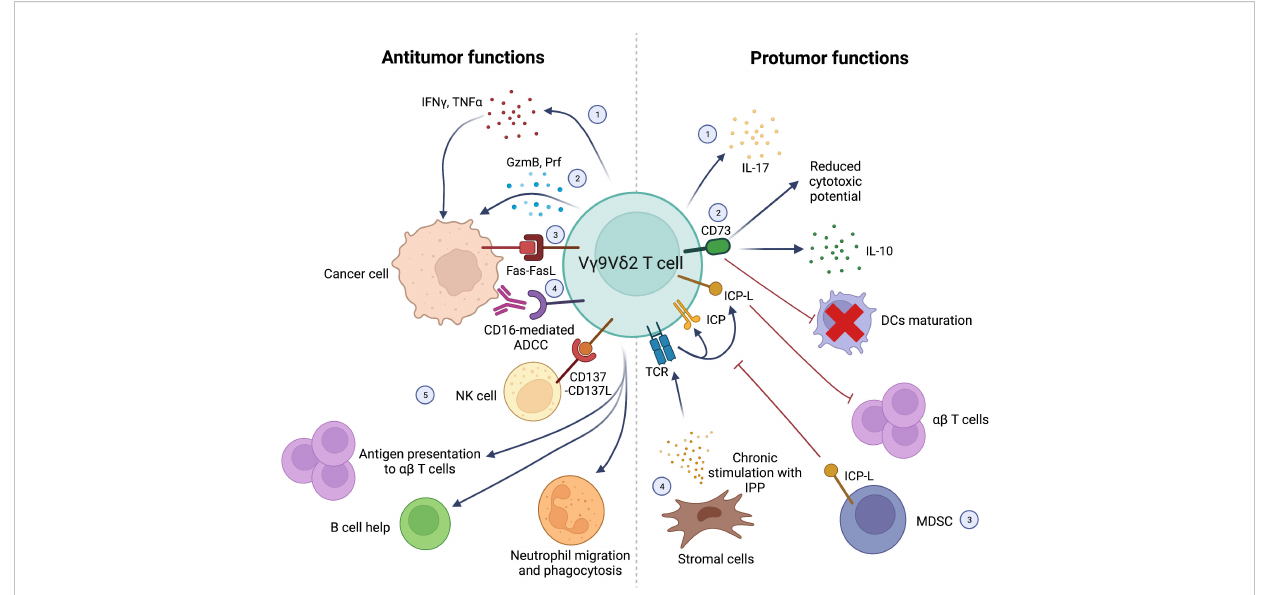
FIGURE 1 Schematic representation of antitumor (left) and protumor (right) functions of V g 9V d 2 T cells. Antitumor functions: 1) IFN g and TNF a production; 2) direct killing of cancer cells via GzmB and Prf production; 3) cancer cell killing via Fas-FasL interactions; 4) CD16-mediated ADCC; 5) synergistic interactions with other immune cells in the TME: NK cells stimulation via CD137L expression; Ag presentation to ab T cells; B cell help; stimulation of neutrophils ’ migration, phagocytosis and a -defensin release. Protumor functions: 1) IL-17 production; 2) CD73 expression leading to IL-10 production, decreased V g 9V d 2 T-cell cytotoxic activity and impaired DCs maturation; 3) Negative regulation of V g 9V d 2 by T-cells MDSC expressing ICP-L (i.e. PD-L1); 4) Chronic stimulation of V g 9V d 2 TCR with IPP produced by stromal cells leading to exhaustion and suppression of ab T cells ’ function through ICP/ICP-L axis. Interferon g (IFN g ), Tumor Necrosis Factor a (TNF a ), Granzyme B (GzmB), Perforin (Prf), Antibody-dependent cell cytotoxicity (ADCC), Antigen (Ag), Interleukin-17 (IL-17), Interleukin-10 (IL-10), Dendritic cells (DCs), Myeloid-derived suppressor cells (MDSC), Immune Checkpont-Ligands (ICP-L), Programmed Death-Ligand 1 (PD-L1), Isopentenyl pyrophosphate (IPP), Immune Checkpoint (ICP). Created with